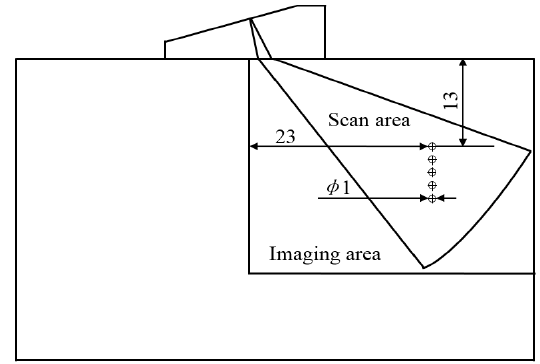
Figure 15. Ultrasonic phased array focusing section Figure 14. Ultrasonic phased array focusing section scan. Figure 14. Ultrasonic phased array focusing section scan.